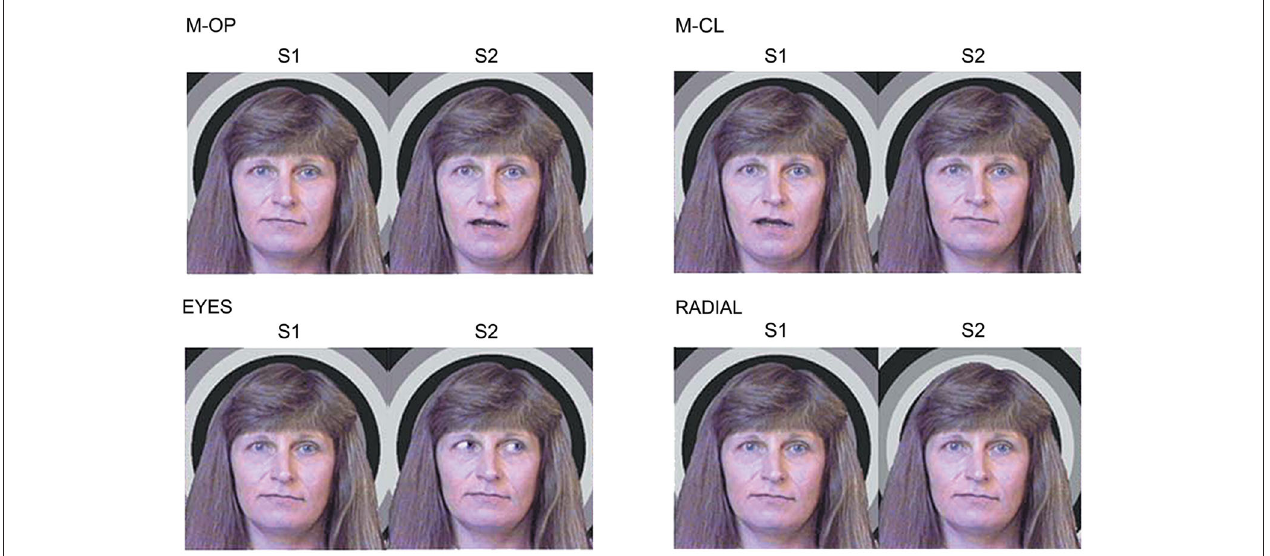
FIGURE 1 | Examples of the stimulus conditions . (1) M-OP: the mouth is opening, (2) M-CL: the mouth is closing, (3) EYES: the eyes are averted, and (4) RADIAL: a radial stimulus moving inward (adopted from Miki et al., 2004).